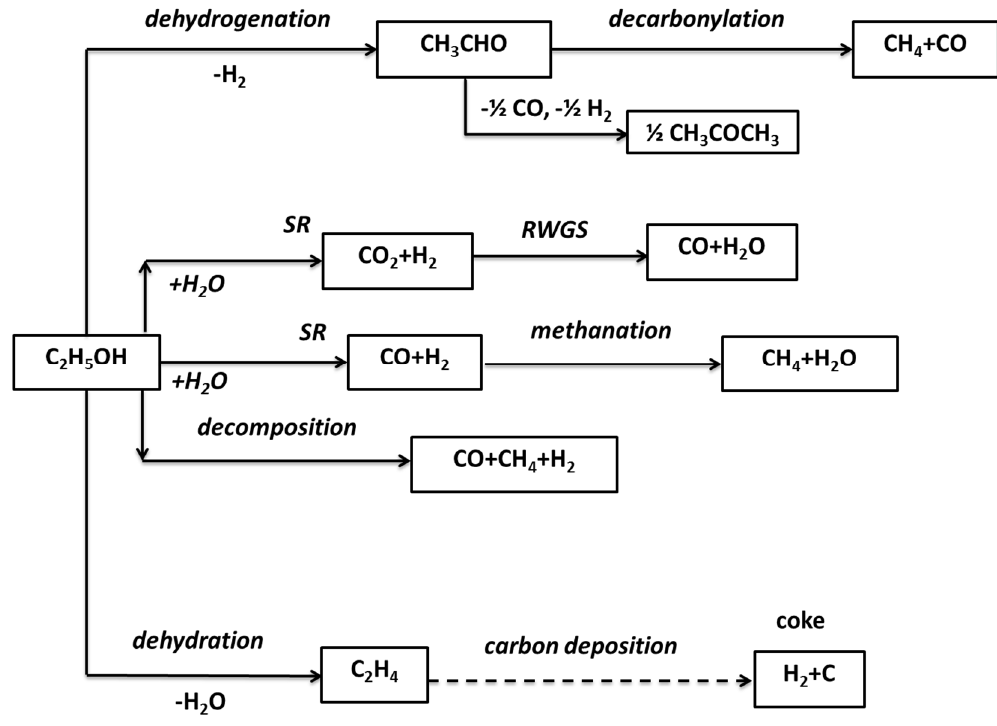
Figure 5. Schematic representation of the reaction network in the ethanol steam reforming (ESR) process.